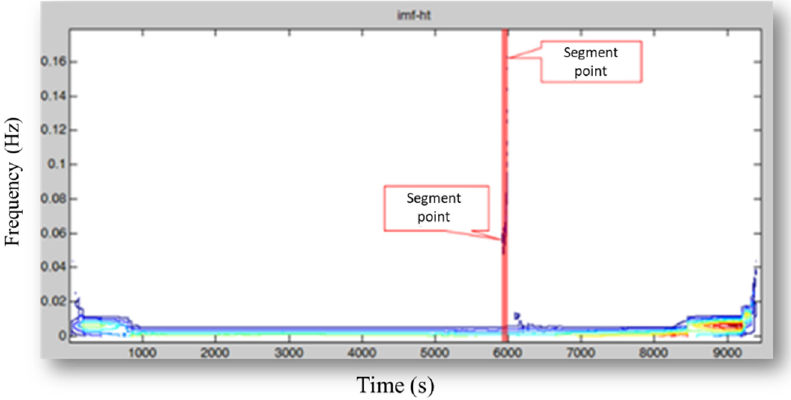
Figure 4. Hilbert’s time-frequency chart.